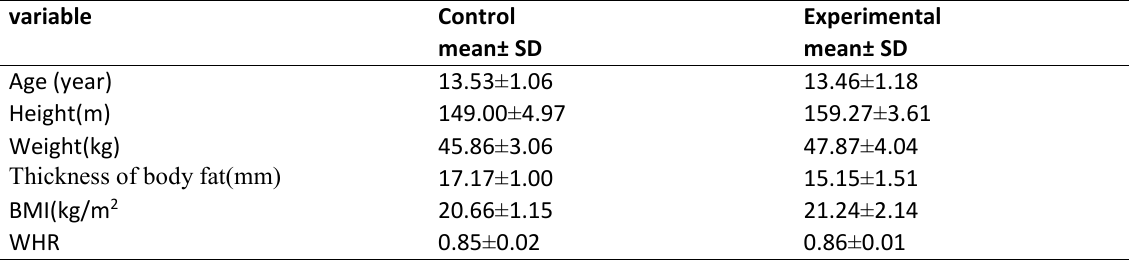
Table2. Baseline characteristics of study participants ( mean± SD)